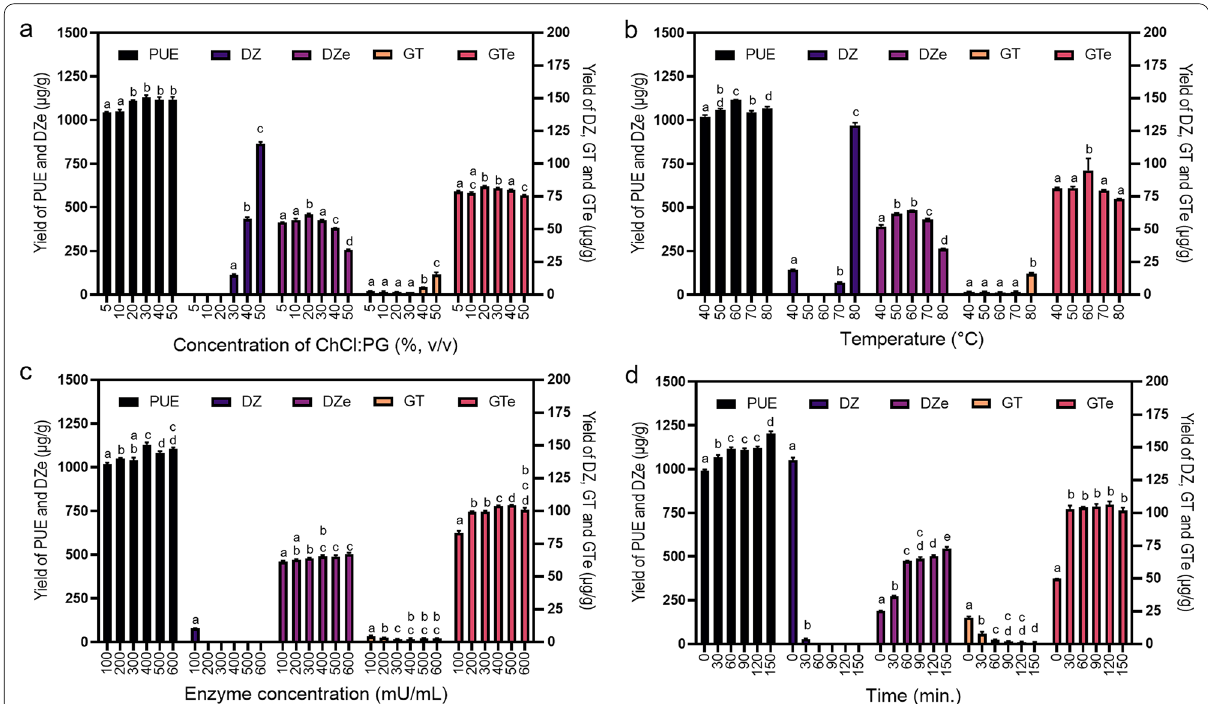
Fig. 3 The effect of each extraction parameter on the extractive yields of PMIs (PUE, DZ, GT, DZe, and GTe), where the concentration of ChCl:PG (1:2) ( a ), temperature ( b ), concentration of cellulolytic enzymes ( c ), and duration of extraction ( d ) were investigated. The same and different letters indicate nonsignificant and significant differences in extractive yields of each compound, respectively, when the data are the levels of each parameter. Statistical significance was determined by one-way ANOVA, followed by LSD ( p <